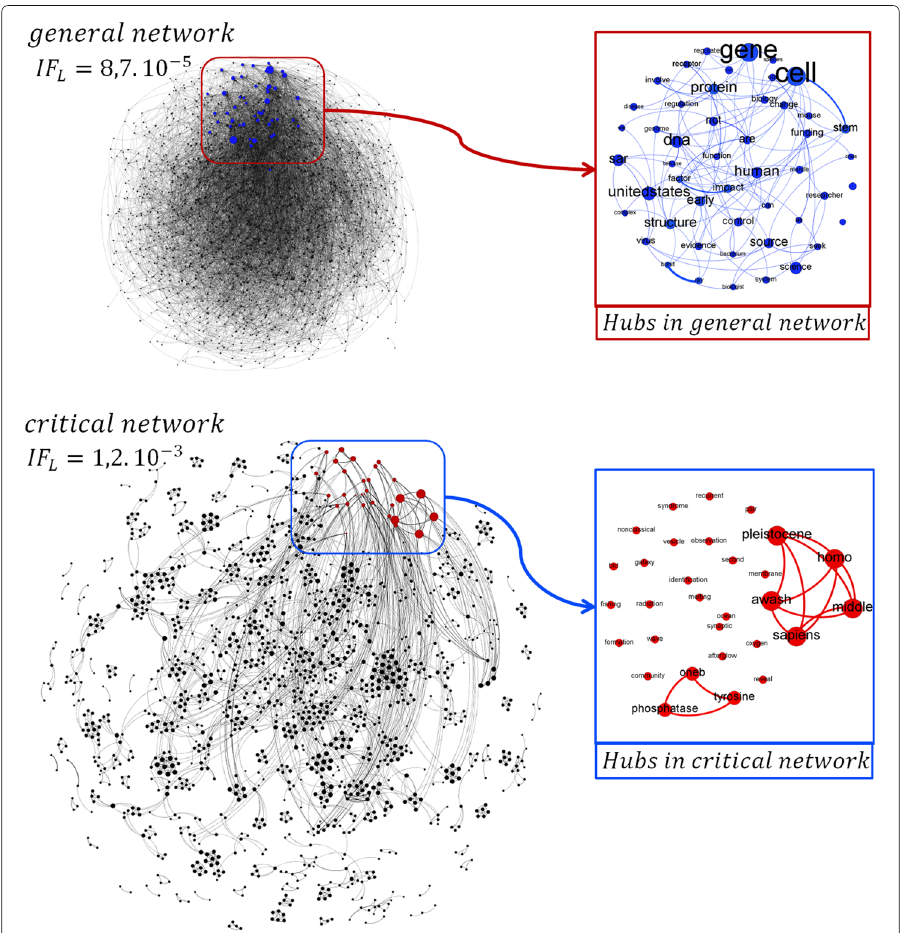
Fig. 9 General network and critical network for Nature in t = 223, with the highest H (cid:12) e . Hubs ( k hub i ≥ (cid:6) k (cid:7) + 2 σ ) for networks are shown without (top line) and with (bottom line) the IF c = IF L ≈ 10 −